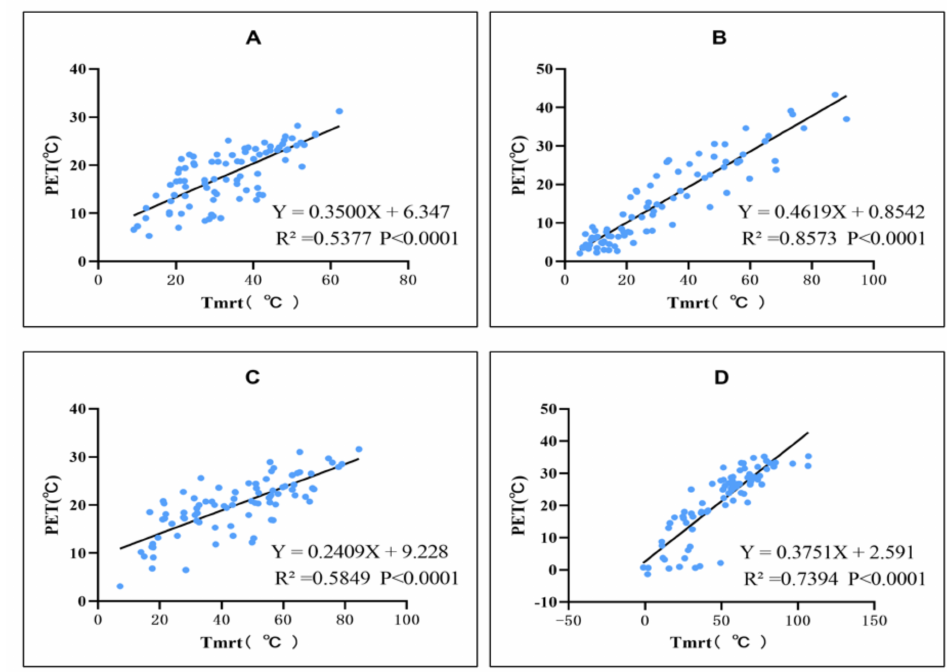
Figure 14. The relationship between PET and Tmrt in different courtyards. (( A – D ) respectively represent the number of the courtyard under